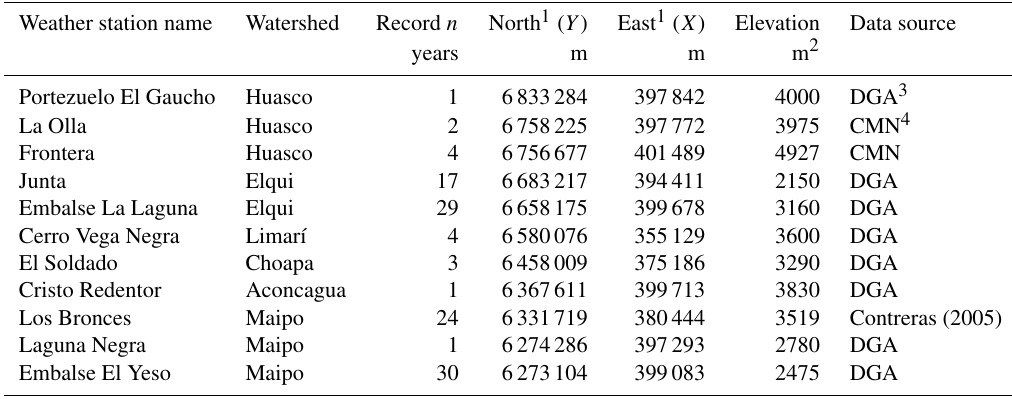
Table 1. Location of the weather stations and number of years between 1981 and 2010 with observations. Weather station